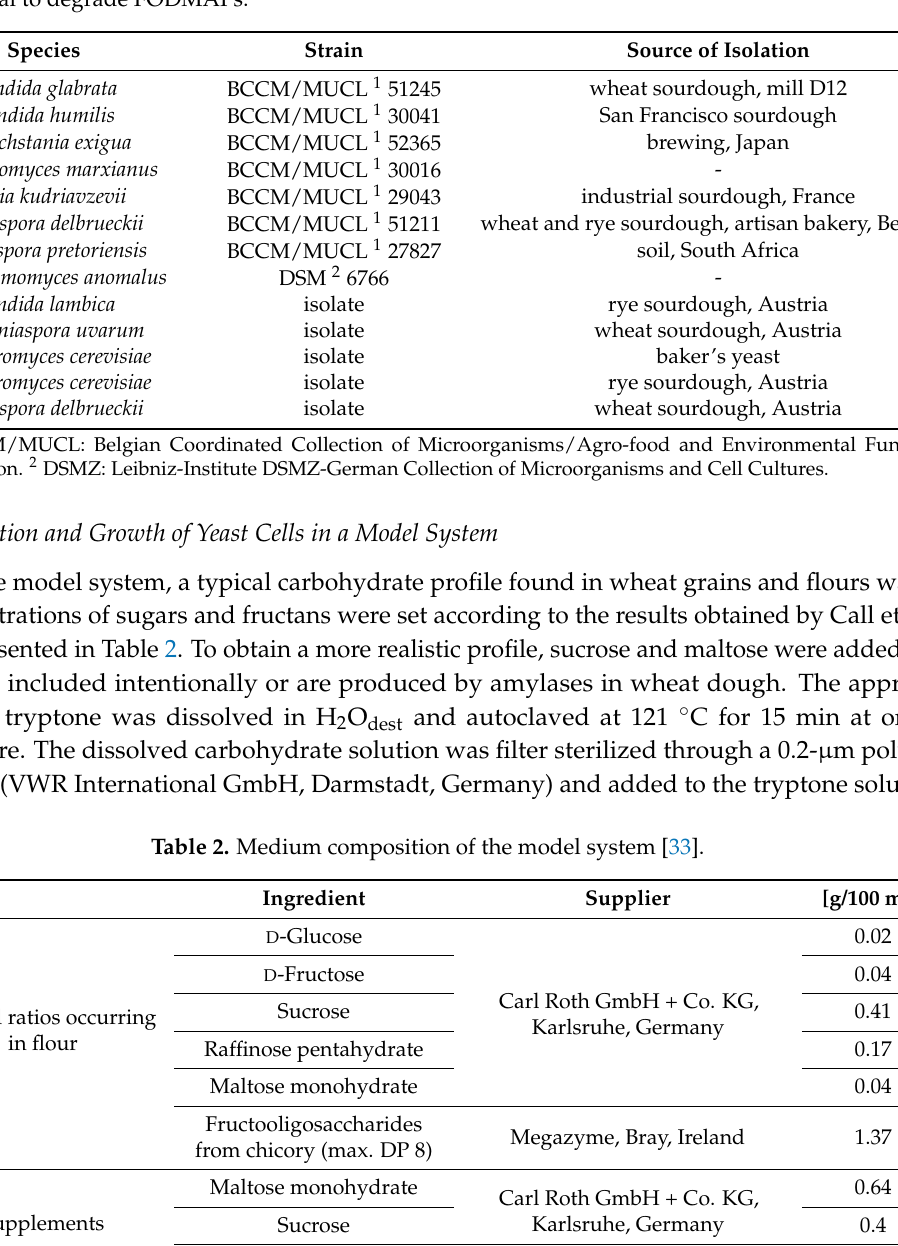
Table 1. Yeast species, strain information, and source of isolation used for the determination of the potential to degrade FODMAPs.